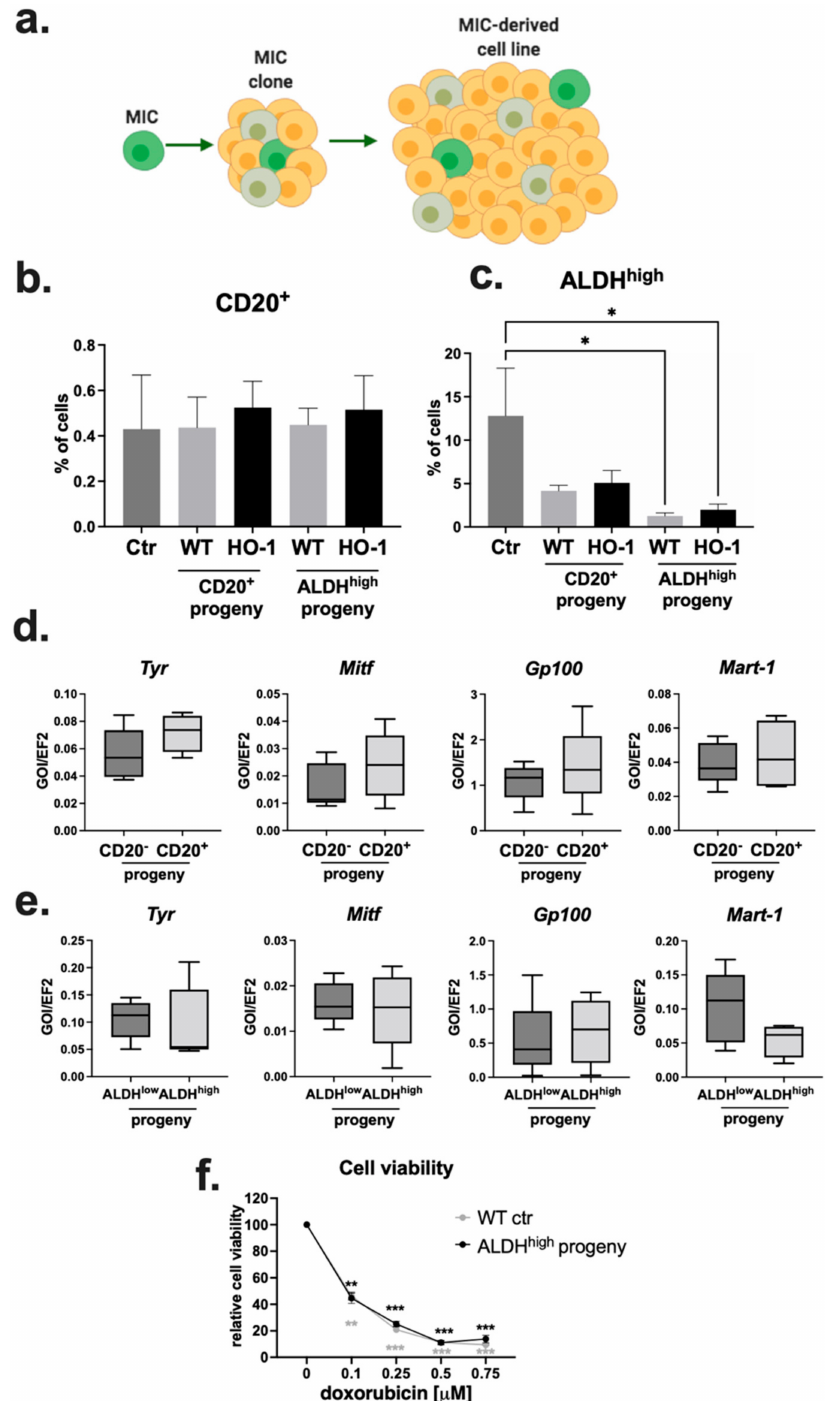
Figure 5. Characterization of MIC-derived clonogenic cell lines. ( a ) The approach used to ob- tain single-cell derived cell lines, illustration created using BioRender. Flow cytometry analysis of the frequency of ( b ) CD20 + and ( c ) ALDH high cells in the parental B16-F10 WT cell line (Ctr) and CD20 + -derived and ALDH high -derived clonogenic cell lines (n = 3–5, each bar represents mean + SEM, * p < 0.05). qRT-PCR analysis of the expression of MAAs in cell lines derived from single ( d ) CD20 − /CD20 + cells and ( e ) ALDH low /ALDH high cells. Ef2 was used as a housekeeping control (n = 5, box and whisker plots). ( f ) MTT reduction assay performed on ALDH high progeny and control cells treated with doxorubicin for 24 h (n = 3, each point represents mean ± SEM; ** p < 0.01, *** p < 0.001 versus untreated